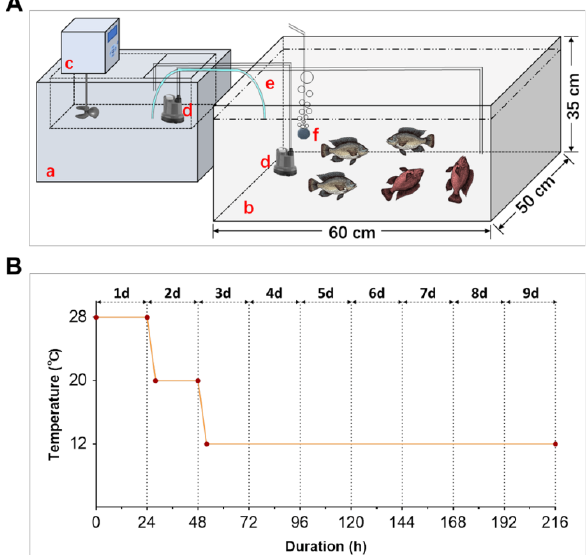
Figure 1. The facilities used for cold exposure and temperature treatment regime. ( A ) Diagram demonstrating the equipment used for cold exposure. A PC200 A40 ARCTIC Refrigerated Circulator from Thermo Scientific was used for temperature control and the fish were held in the customized plastic box. Components: a, refrigerated circulator; b, customized plastic box; c, controller of the circulator; d, mini pumps (40 W, 2000 L/h); e, siphon pipe; f, air stone. The fish that lost equilibrium are shown in red. ( B ) Line chart illustrating the gradient temperature regime for cold exposure. The red dots indicate the beginning and ending time of treatment for each temperature.